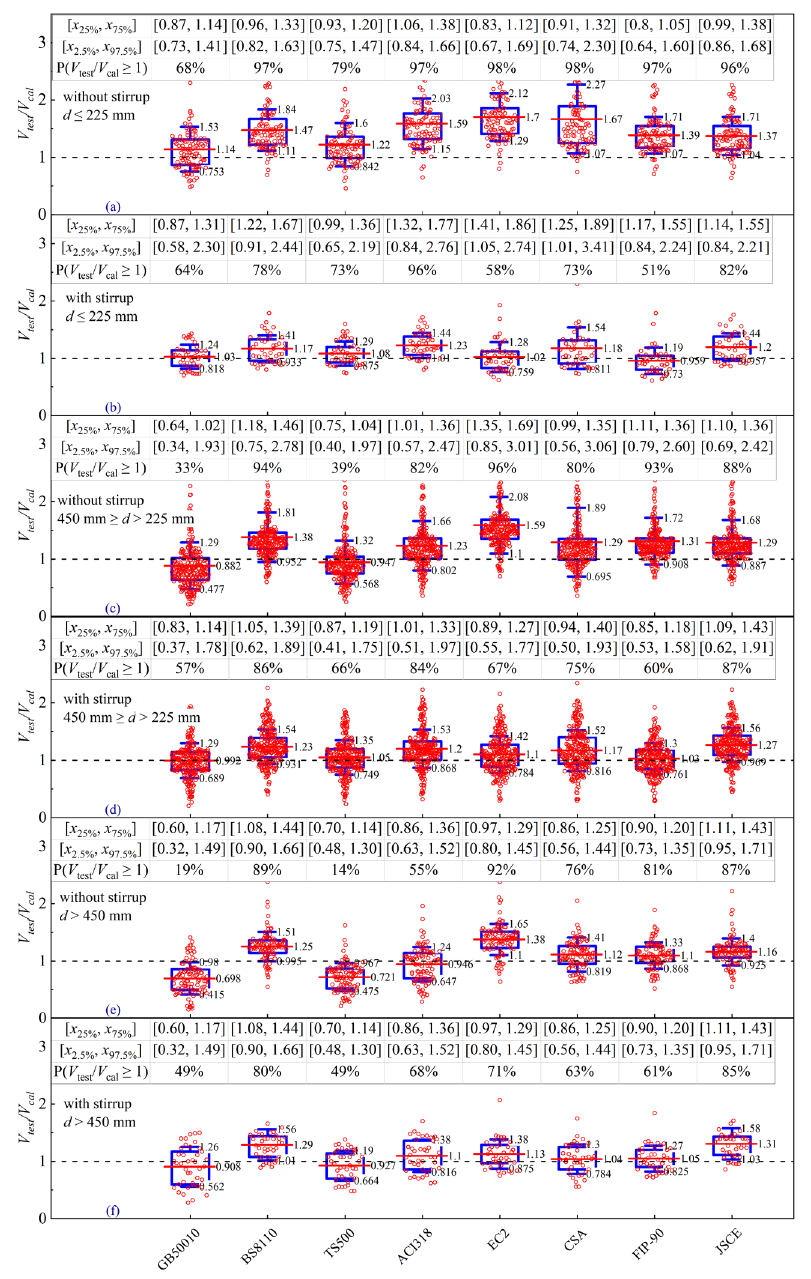
Figure 10. Codes: prediction results for beams without stirrup versus ( a ) d ≤ 225 mm; ( c ) 225 mm < d ≤ 450 mm; ( e ) d > 450 mm and for beams with stirrup versus ( b ) d ≤ 225 mm; ( d ) 225 mm < d ≤ 450 mm; ( f ) d > 450 mm .